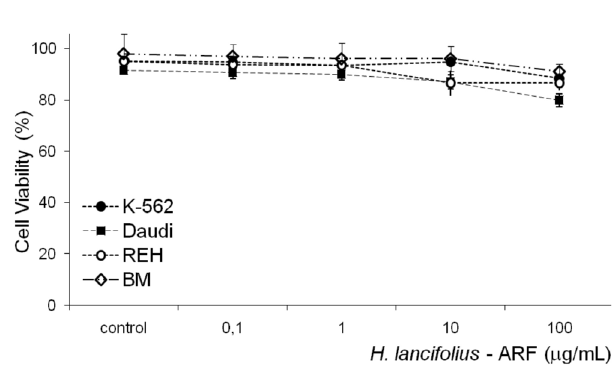
FIGURE 3 - Cytotoxic effects of H. lancifolius alkaloid-rich fraction on leukemic and normal cells. Cells in log phase were treated with the indicated doses of ARF for 48 h, at 37 °C. Each point represents the percentage of viable cells ± EPM recovered after trypan blue exposure from at least 3 experiments, each performed in triplicate. [*] p <0.001.